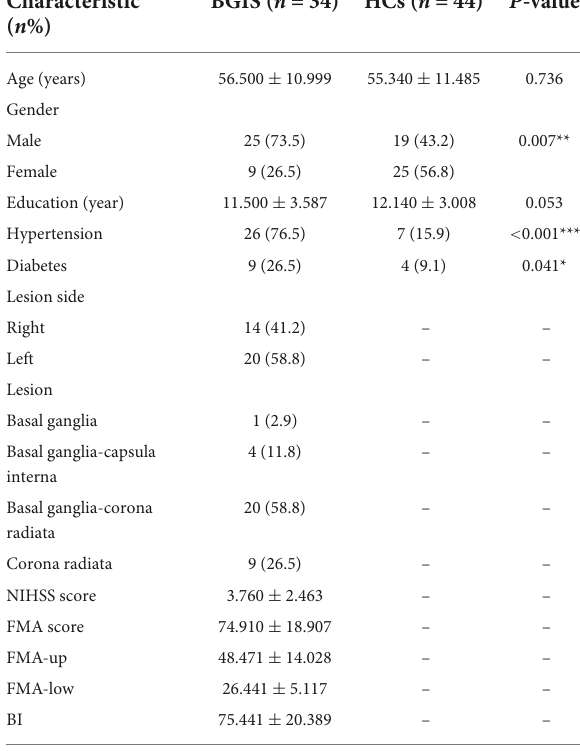
TABLE 1 Demographic and clinical characteristics of the